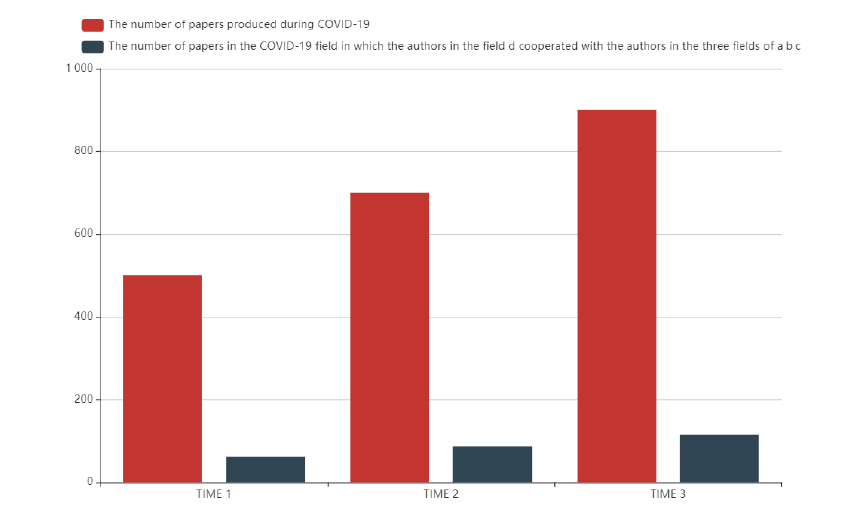
Figure 8. When 500, 700, and 900 articles were generated during the COVID-19 period, respectively, the number of articles in the COVID-19 field in which the authors in the field d cooperated with the authors in the first three fields are shown. Three parts (TIME1, TIME2, and TIME3) are shown in this